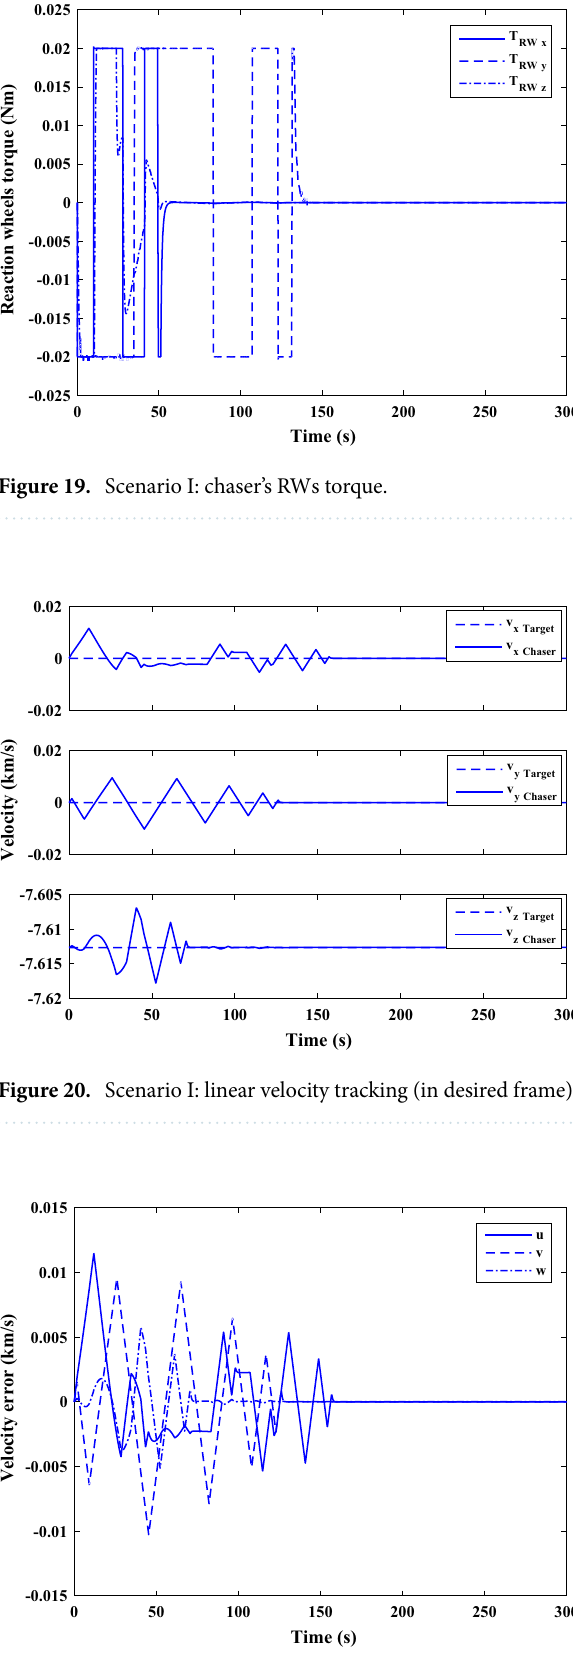
Figure 21. Scenario I: relative linear velocity error (in desired